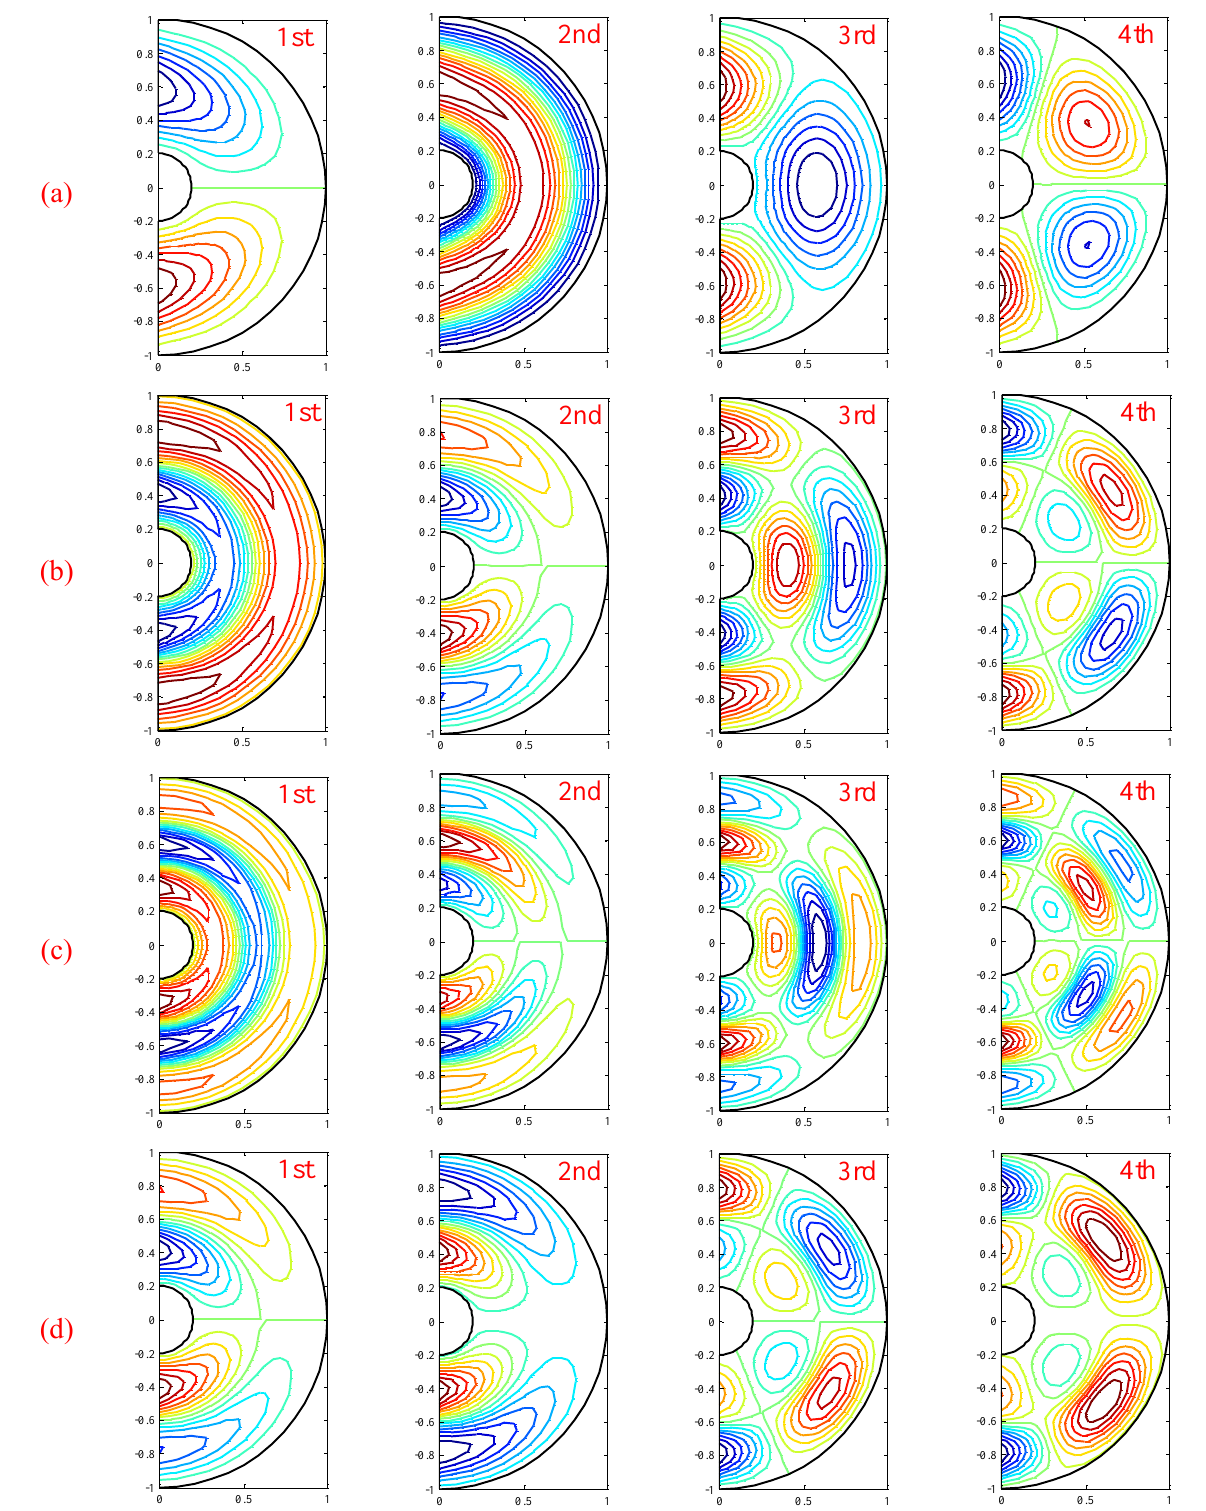
Figure 14: The lowest four mode shapes for a CFCF laminate annular sector plate with various line supports:(a) None; (b) r 1 = R /2; (c) r 1 = R /3, r 2 =2 R /3; (d) r 1 = R /2, θ 1 = ϕ /2;(e) r 1 = R /3, θ 1 = ϕ /2, r 2 =2 R